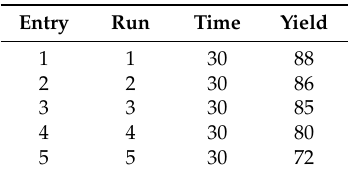
Table 4. Reusability of [Et 3 NH][HSO 4 ] catalyst for model reaction 6a